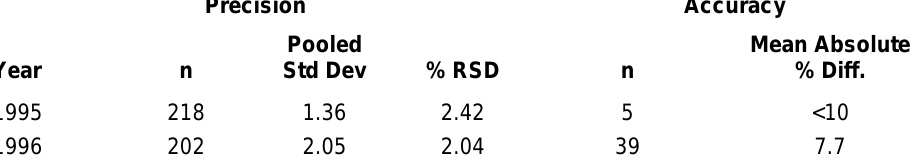
Precision and Accuracy for the Passive Samplers